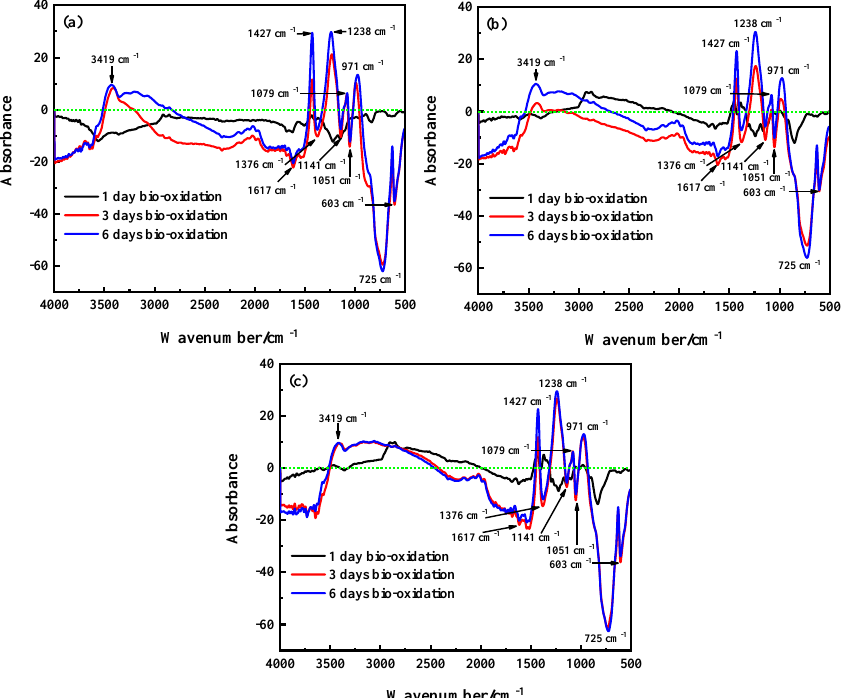
Figure 4. FTIR spectra (difference spectrum) of DRGO after oxidizing 1, 3 and 6 in 9 K culture medium. ( a ) A. ferrooxidans ; ( b ) L. ferrooxidans ; ( c ) Mixed culture.